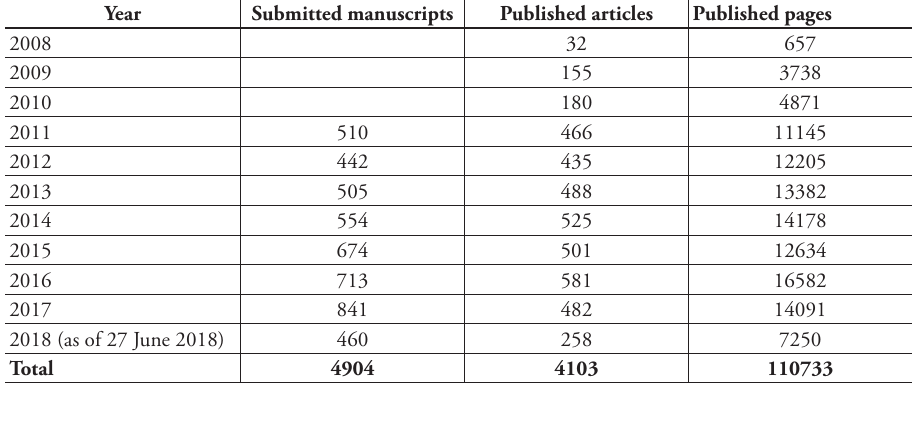
Table 1. Total number of submitted manuscripts published articles, and printed pages since 2008. No accurate data for number of submissions 2008–2010.